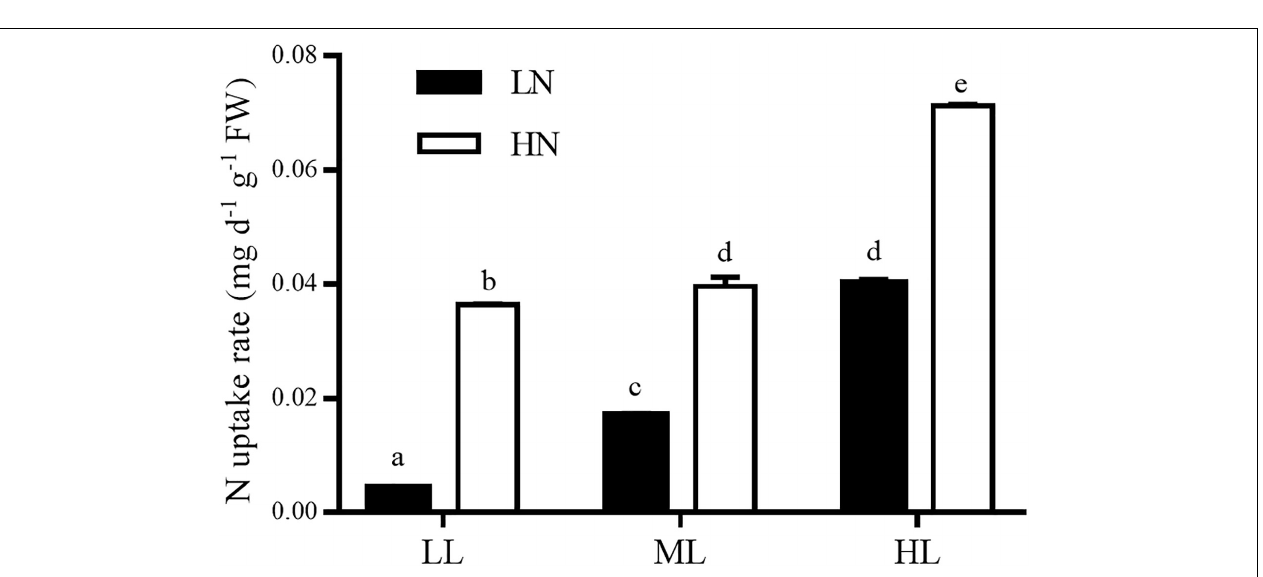
FIGURE 5 | Content of soluble proteins in S. muticum grown at different light and nitrogen levels for 12 days. Significant ( P < 0.05) differences among the treatments are indicated by different lowercase letters. Vertical bars represent ± SD for the means of three samples.